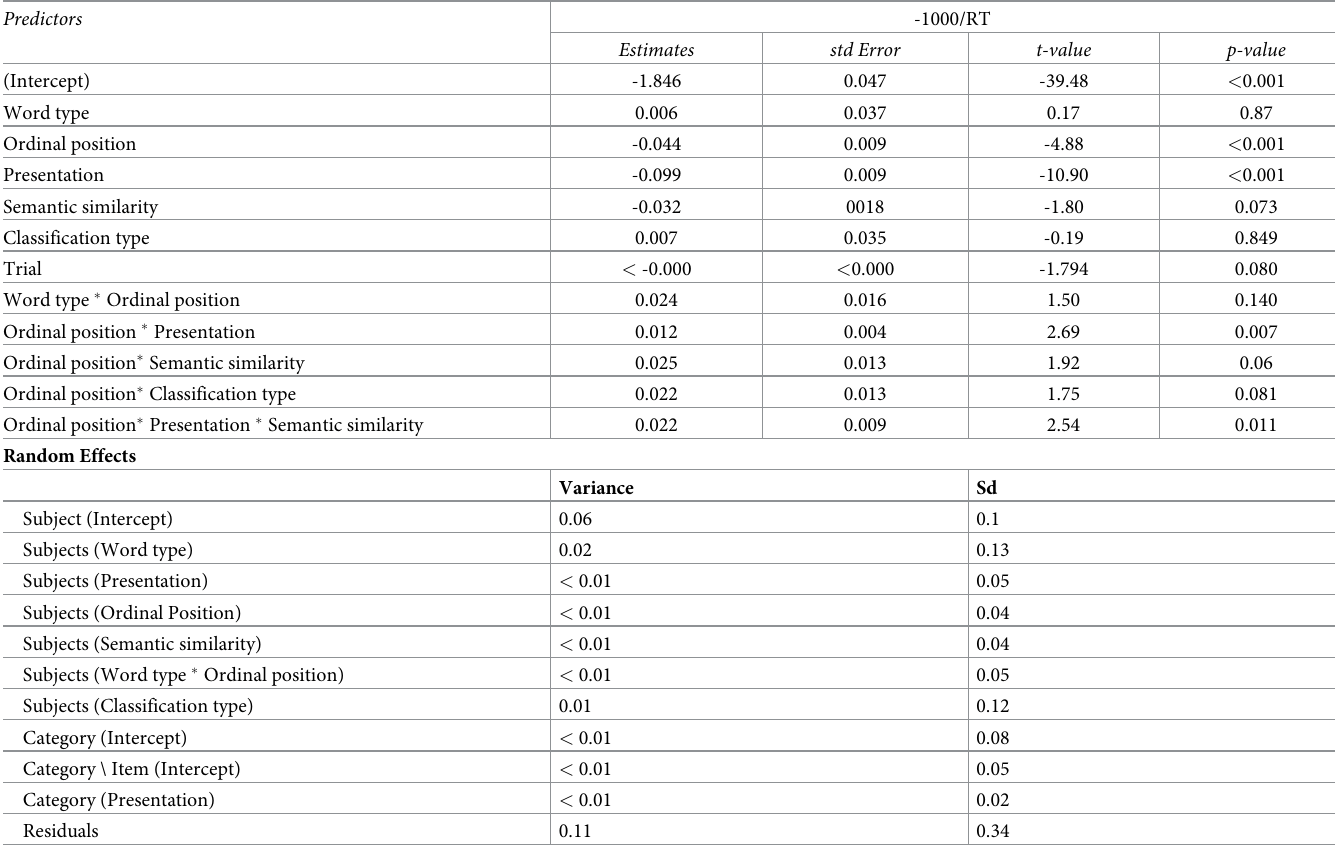
Table 2. Main model Experiment 2. -1000/RT ~ Word type � Ordinal position + Ordinal position � Presentation+ Ordinal position: Semantic similarity: Presentation + Ordinal position: Semantic similarity + Semantic similarity + Ordinal position � Classification type+ Trial+(Word type � Ordinal position +Presentation+ Semantic